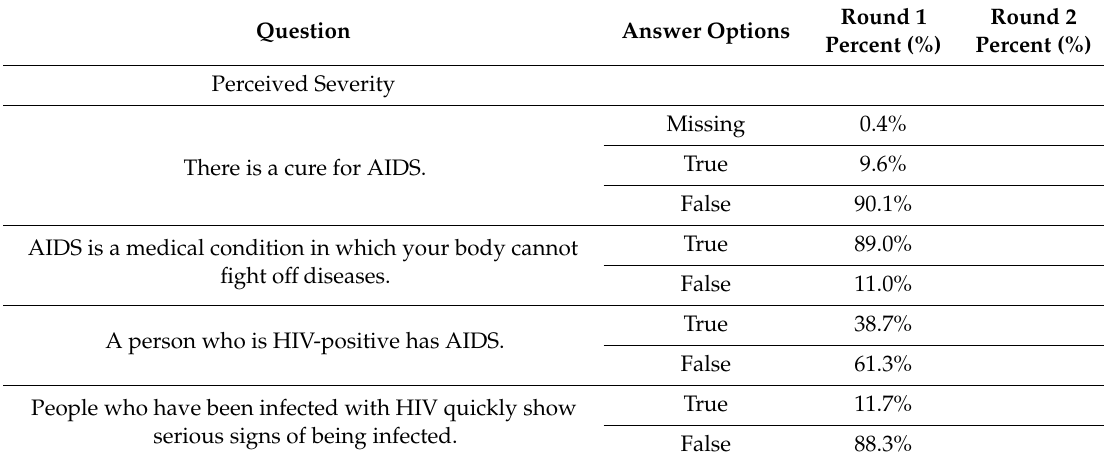
Table 3. Perceived severity of HIV among college students (n =